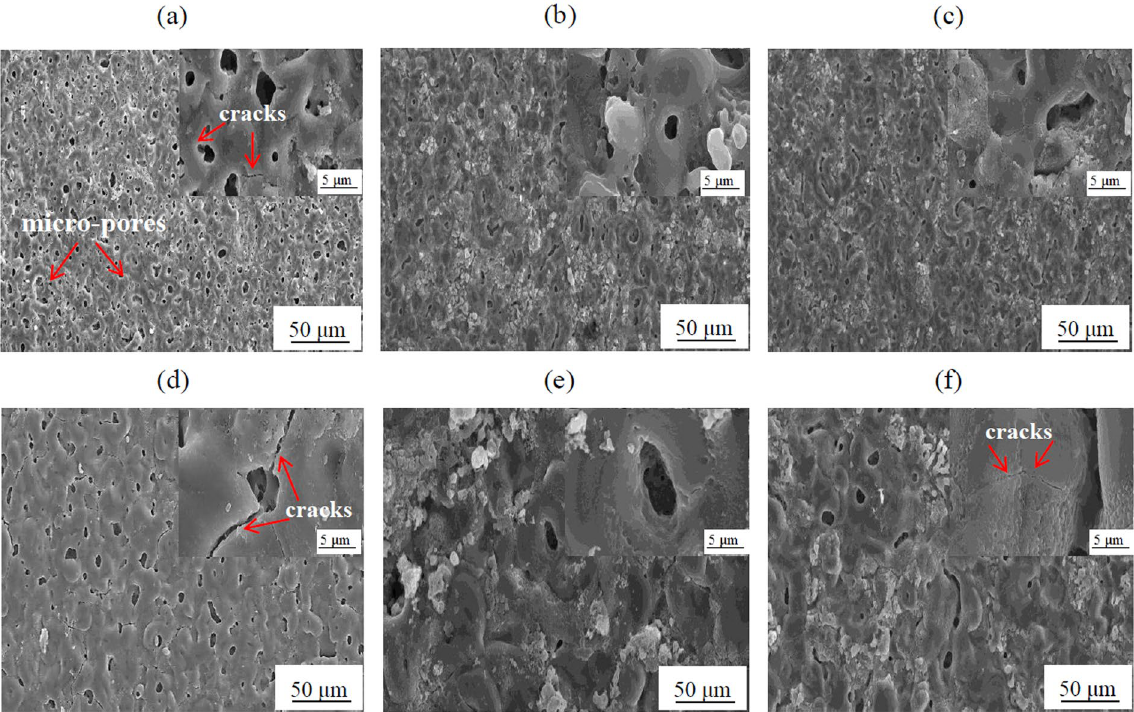
Figure 1. SEM images showing the surface morphology of the coatings formed on an Al-Mg-Si alloy by PEO at 50 mA/cm 2 ( a – c ) and 125 mA/cm 2 ( d – f ) in an electrolyte containing no Na 3 AlF 6 ( a and d ), 1.5 g/L Na 3 AlF 6 ( b and e ), and 3 g/L Na 3 AlF 6 ( c and f ). Insets are the high-magnification images of the surface morphology of the PEO coatings.